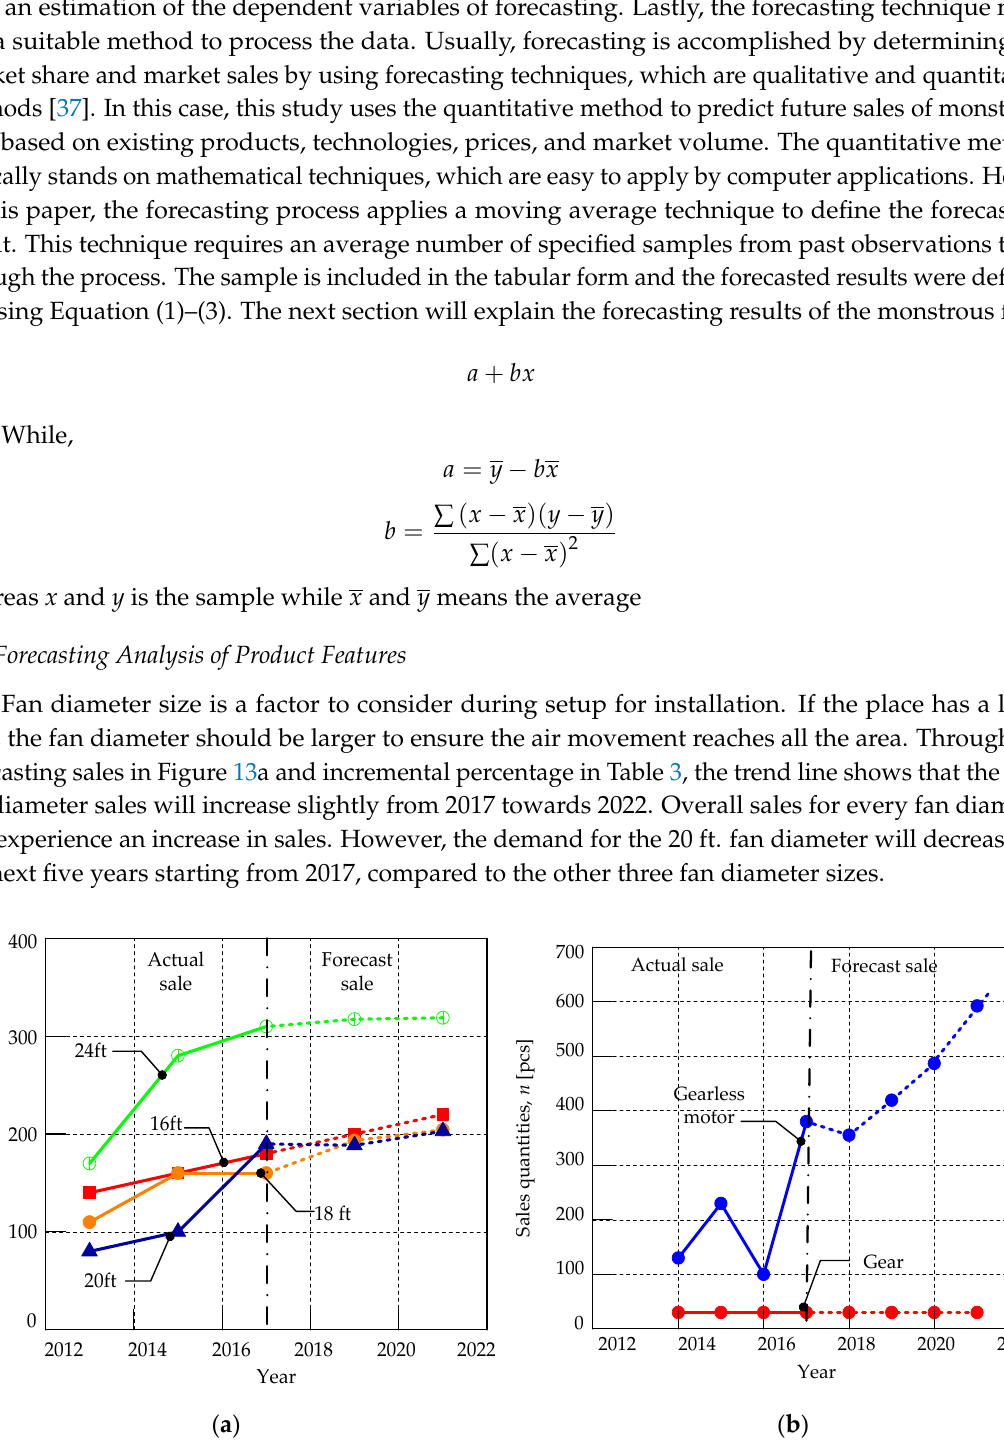
Figure 13. Forecasting analysis ( a ) Monstrous fan diameter forecasting ( b ) Monstrous fan technology forecasting .